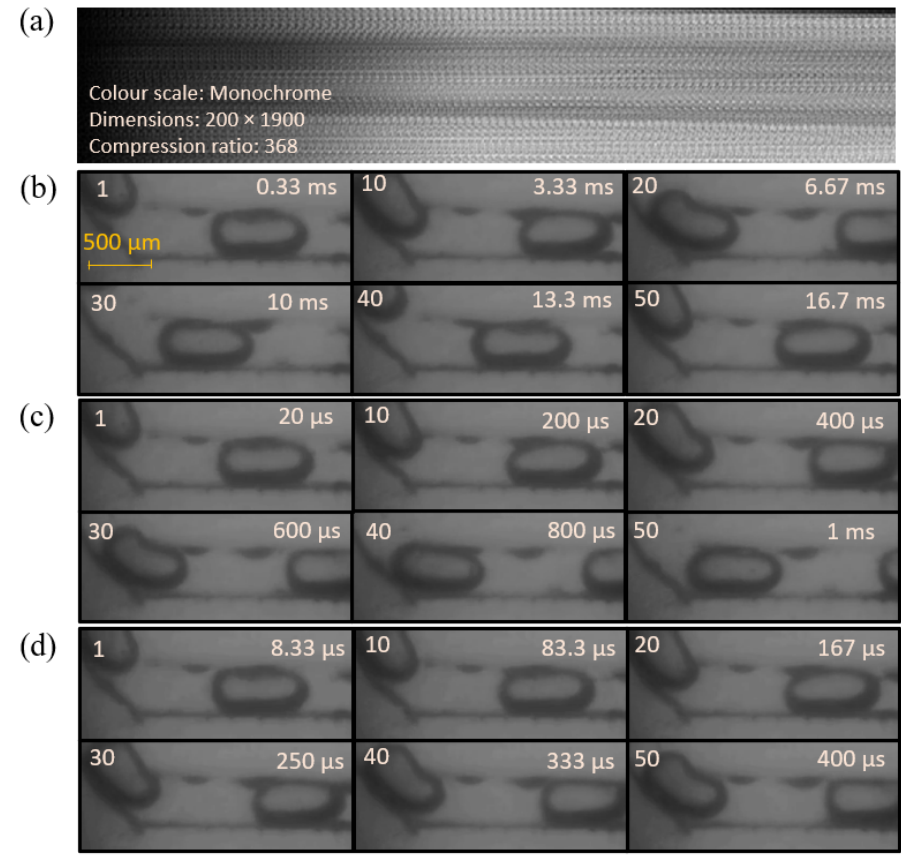
Figure 3. ( a ) Capture of the microfluidic chip at the frame rate of 120 Kfps and reconstructed frames from the captures at frame rates of ( b ) 3, ( c ) 50 and ( d ) 120 Kfps. Frame numbers and time instance of the frames are shown in the top left and right corners of each frame,